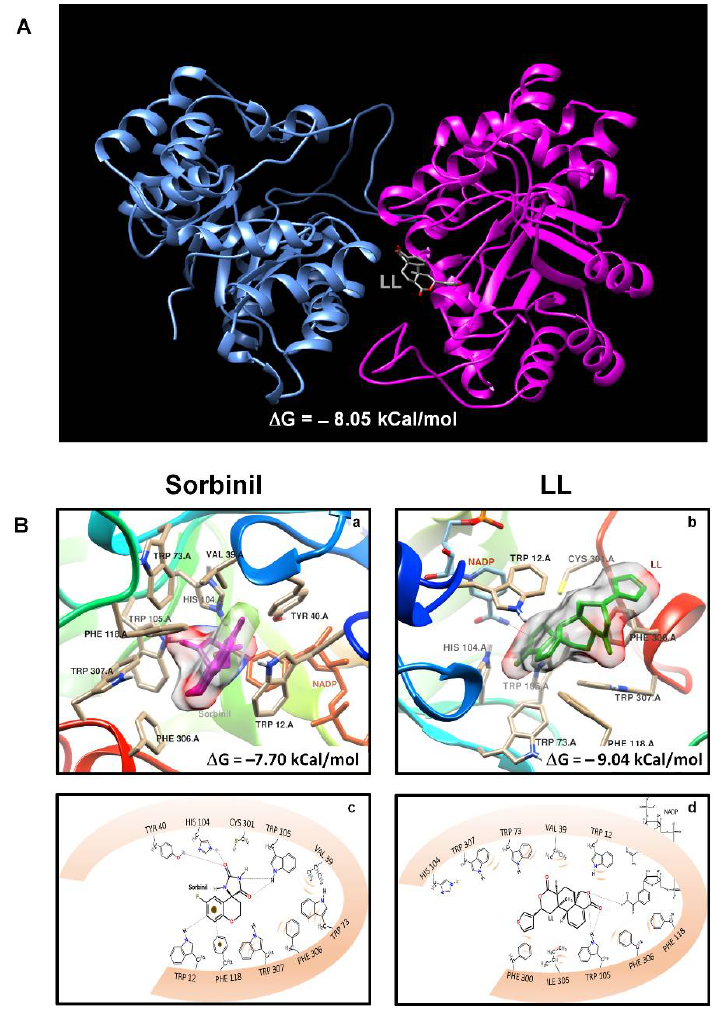
Figure 6. Linearolactone (LL) is a diterpene with a high affinity for aldose reductase from G. intestinalis (GdAldRed). ( A ) Molecular docking performed in “blind” mode with LL dimer displayed in stick conformation (blue and red). The free Gibbs energy value ( G) is indicated. ( B ) Molecular cou- pling of the active site of GdAldRed with sorbinil (GdAldRed inhibitor) ( a ) and LL ( b ). The affinity and bonds established by the molecular coupling with GdAldRed with sorbinil ( c ) and LL ( d ). The G data are expressed in kCal/mol.